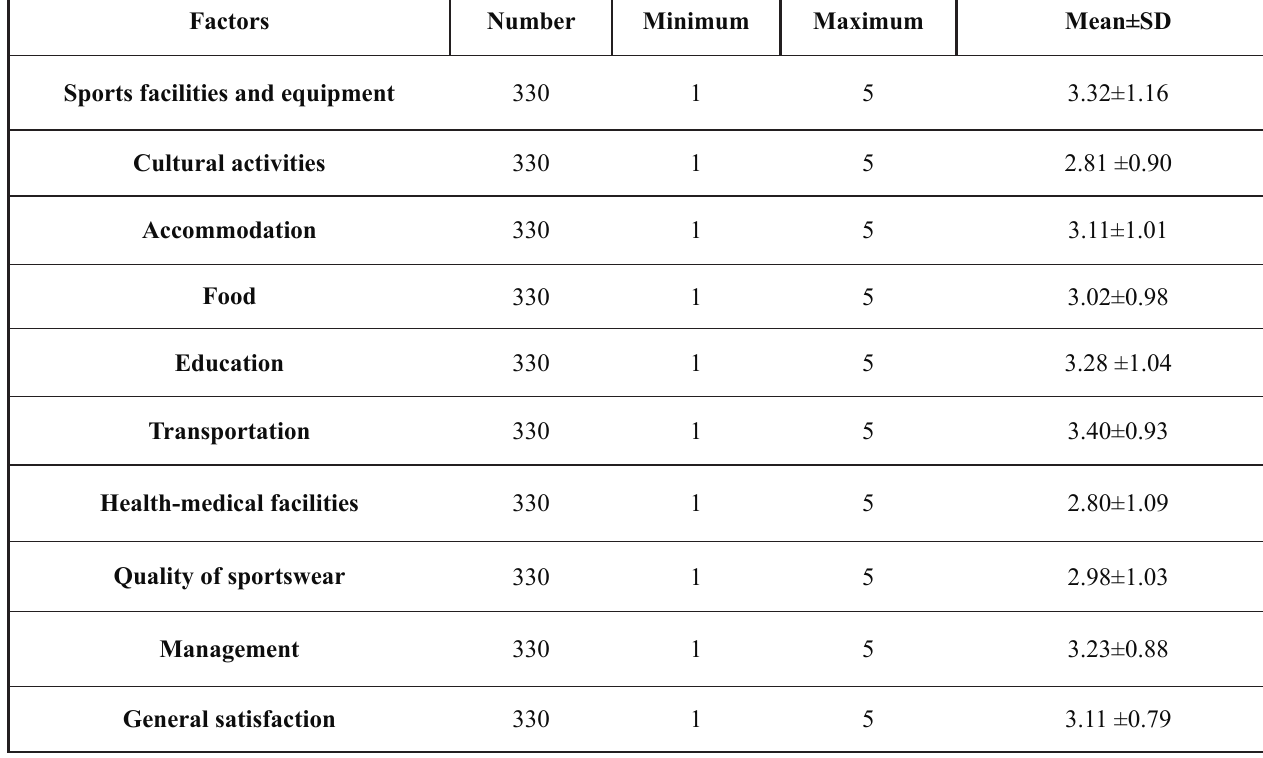
Table 2. Evaluation of satisfaction of university students with sports camps before and after